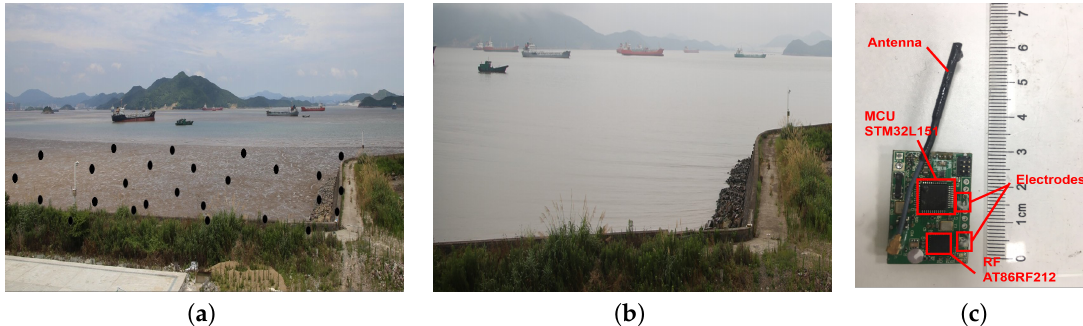
Figure 1. The illustration of the intertidal wireless sensor network in Zhoushan. ( a ) Nodes deployment with low tide in Zhoushan; ( b ) High tide in Zhoushan, all nodes are submerged; ( c ) The hardware design of the sensor